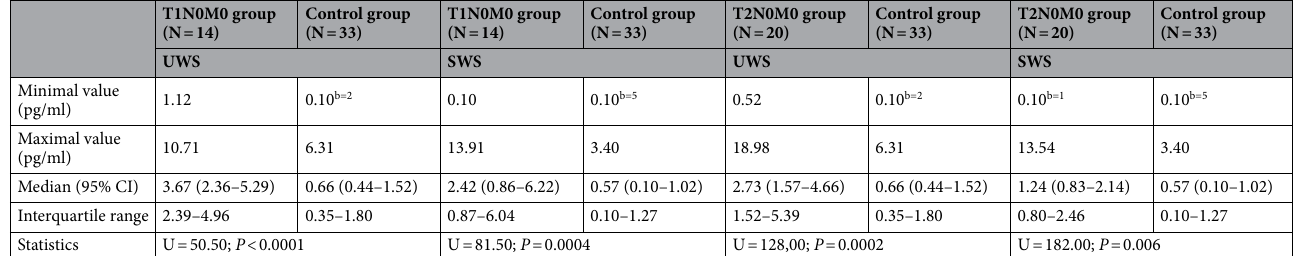
Table 3. Melatonin levels comparison in unstimulated and stimulated whole saliva between oral squamous cell carcinoma subgroups and control group. a OSCC oral squamous cell carcinoma, CI confidence